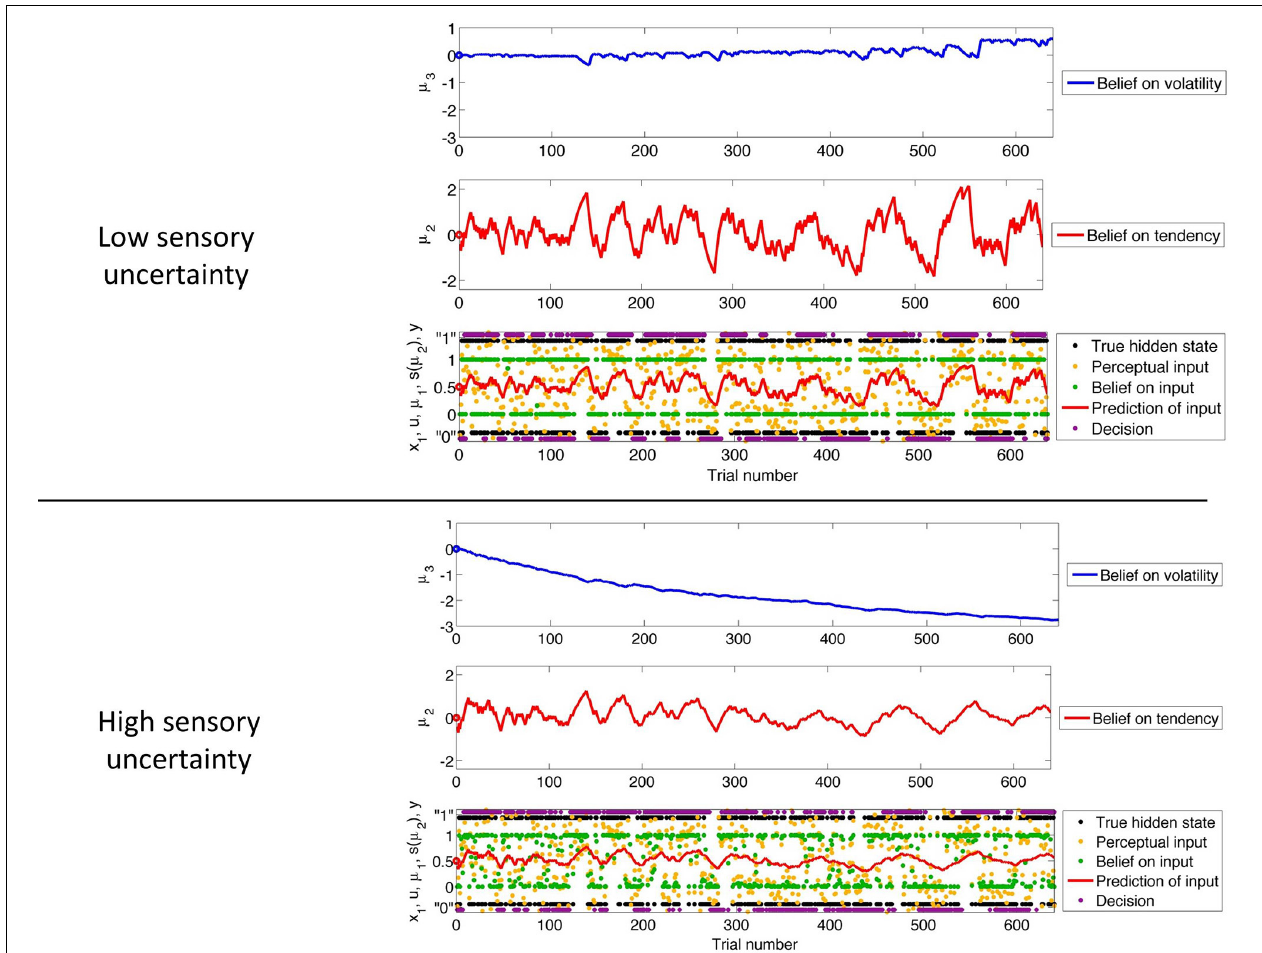
Trajectoriesweresimulatedusingthesameinputandparameters(except (cid:4) π u )in both cases: μ (0) 2 = μ (0) 3 = 0, σ (0) 2 = σ (0) 3 = 1, κ = 1, ω = − 3, and ϑ = 0 . 7. Decisions were simulated using a unit-square sigmoid model with ζ =